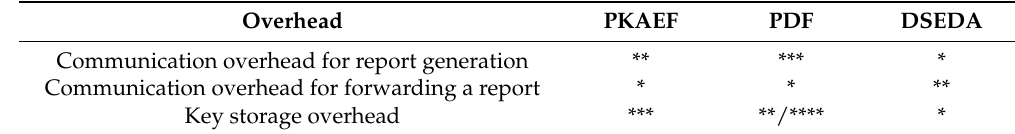
Table 2. Comparison of